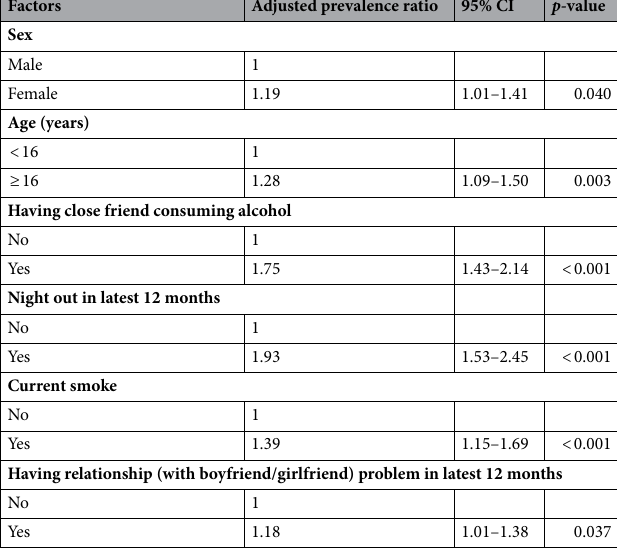
Table 4. Multivariable analysis for factors associated with last 12-month alcohol consumption among adolescents in a rural community, central, Thailand. Adjusting for sex, age, having close friend consuming alcohol, night out, current smoke, having relationship (with boyfriend/girlfriend) problem. CI confidence